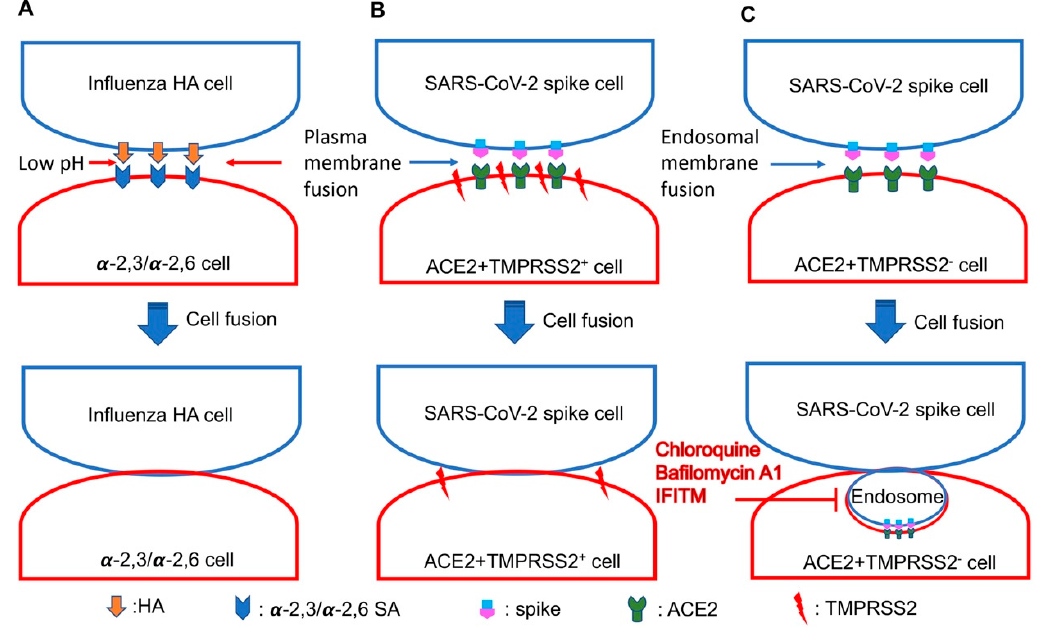
Figure 1. The schematic model of HA- and spike-mediated cell fusions. ( A ) Influenza HA binds to sialic acids linked to galactose via an α -2,3 bond or α -2,6 bond ( α -2,3/ α -2,6 SA). Influenza virus HA can trigger cell–cell membrane fusion after the low pH challenge. ( B ) SARS-CoV-2 spike binds to ACE2 to trigger cell–cell plasma membrane fusion when there is TMPRSS2 on the cell membrane. ( C ) SARS-CoV-2 spike binds to ACE2 to trigger cell–cell membrane fusion through the endocytic pathway when there is no TMPRSS2 on the cell membrane. The two adjacent cell membranes with spike-ACE2 binding can bend to undergo endocytosis, which can provide the low pH in the endosomes to allow cathepsin B/L to cleave the S2 site to trigger the fusion. This kind of fusion can be blocked by endosomal inhibitors (chloroquine, bafilomycin A1 or IFITM).